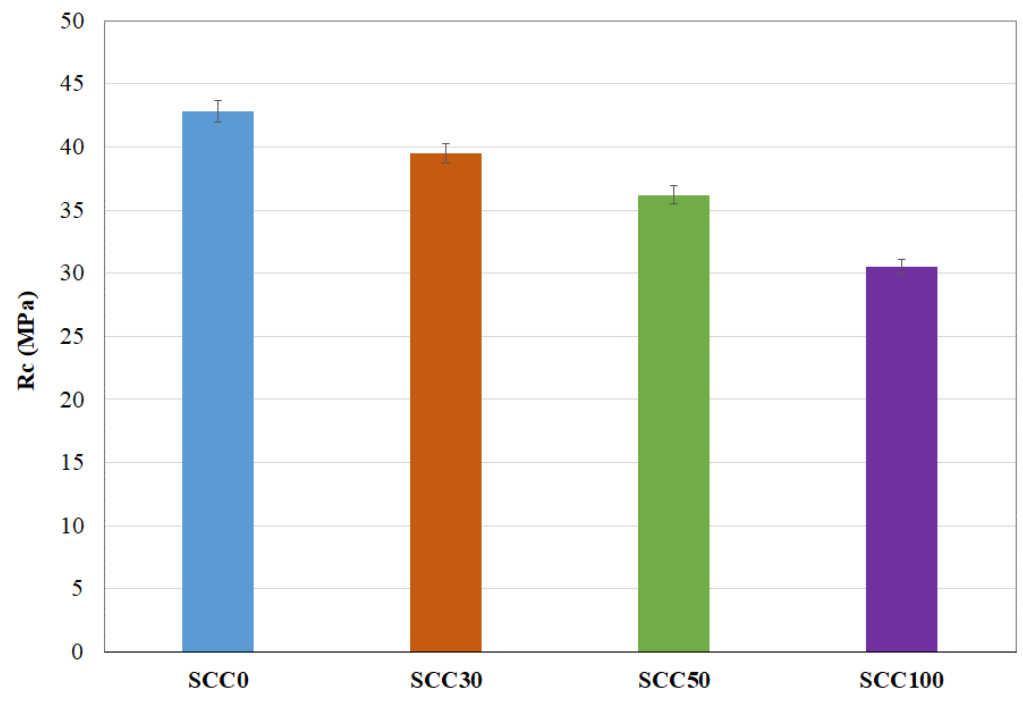
Figure 4. Compressive strengths results at 90 days.